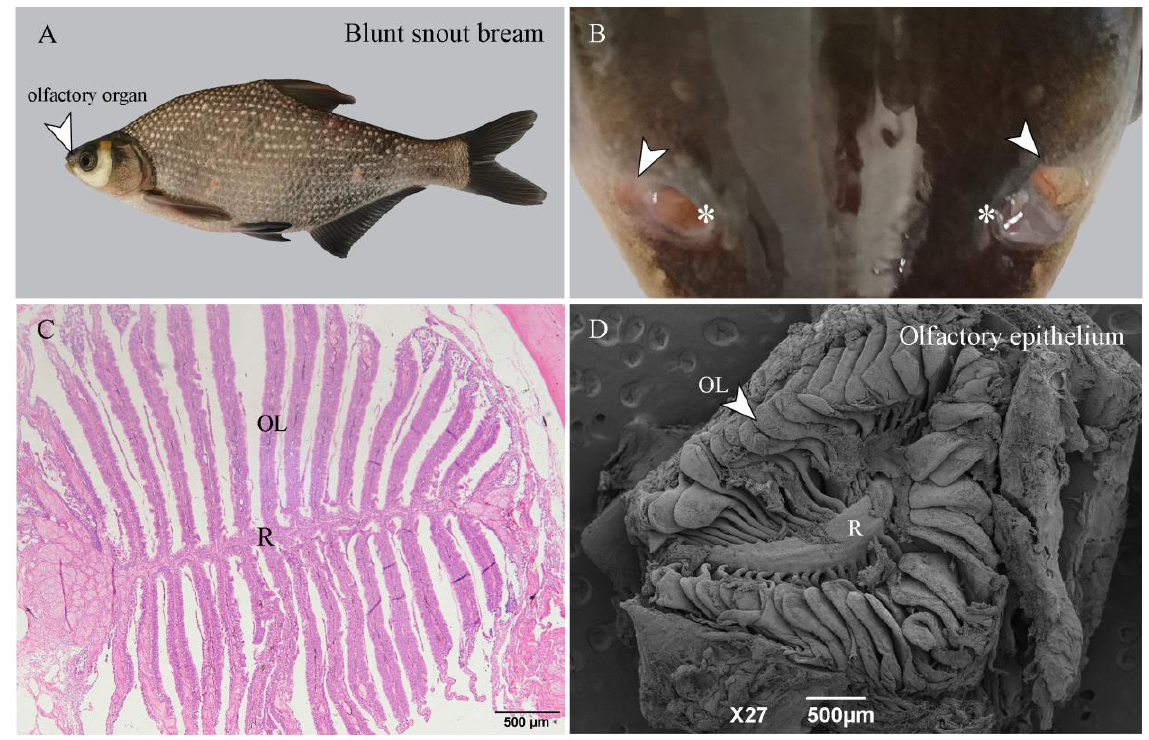
Figure 9. OE of blunt snout bream. ( A ) Blunt snout bream specimen. ( B ) Location of OE (arrows) and anterior nostrils (*) on blunt snout bream. ( C ) H.E. staining of OE of blunt snout bream. R: olfactory raphe; OL: olfactory lamellaes. ( D ) Scanning electron microscopy of OE of blunt snout bream.